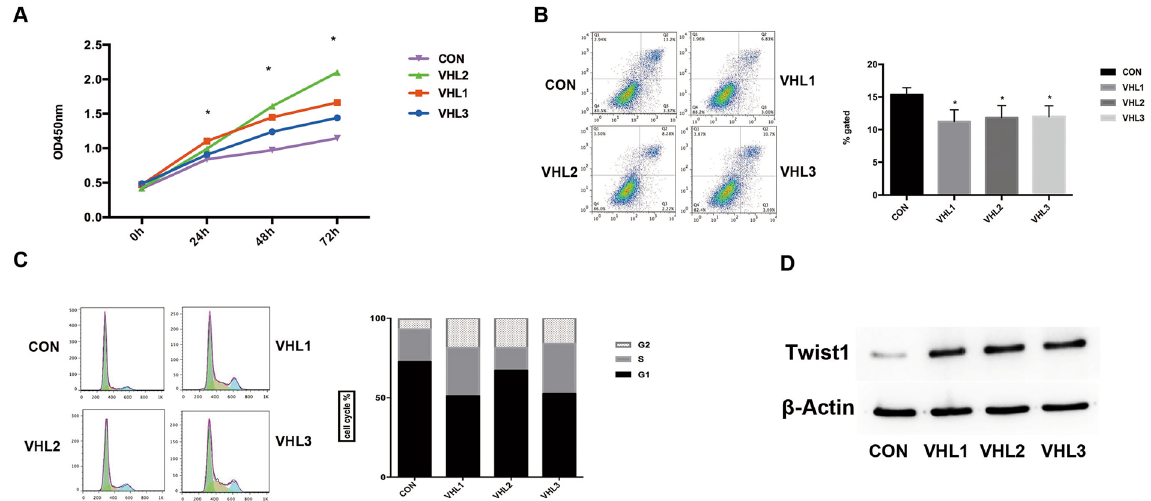
Figure 2. The effect of VHL gene knockdown on proliferation and apoptosis of HUVEC cells in vitro . Knockdown of VHL gene expression significantly promoted proliferation ( A ) and decreased apoptosis ( B ) of HUVEC cells in vitro . An increase in the percentage of cells in S or G2/M phase in sh-VHL groups was observed compared to the control group (P < 0.05) ( C ). Western blots results showed knockdown of VHL up-regulated Twist1 expression in HUVEC cells ( D ). All these data were representative of three independent experiments. Statistical analysis was performed using unpaired Student’s t test, * represent P < 0.05. The original figure of western blotting was shown in Supplementary Figure